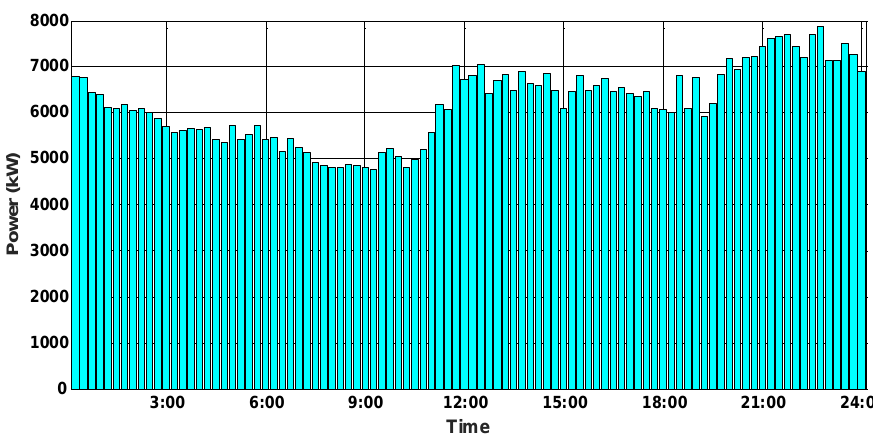
Figure 5. The space-time distribution of electrical vehicles.